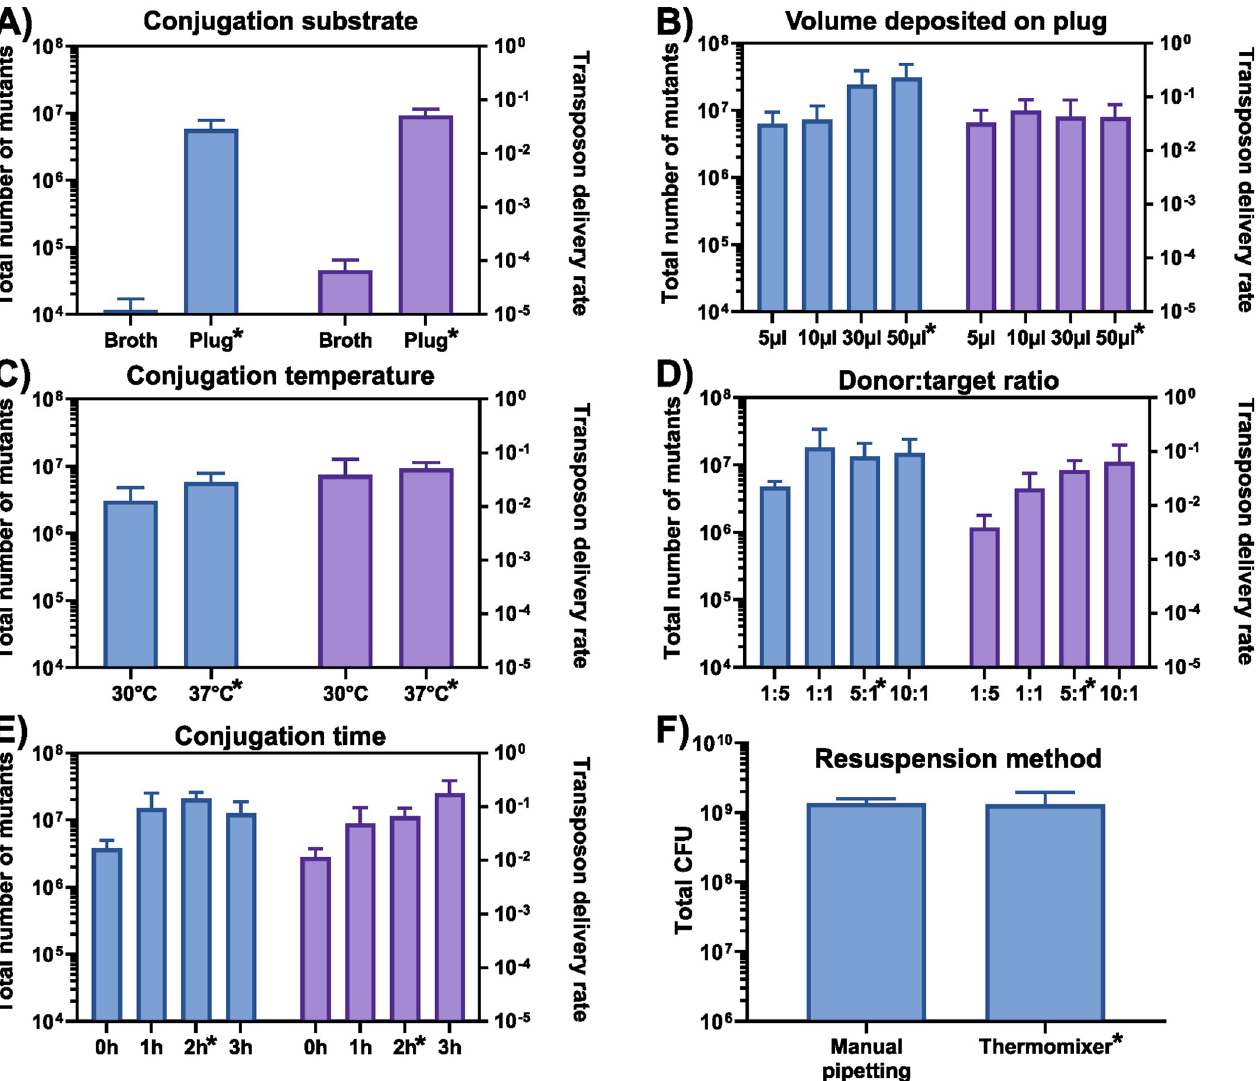
Fig 3. Optimization of key HTTM parameters. The total number of insertion mutants generated (blue) and the overall method efficiency (purple) were quantified while testing selected parameters such as A) the conjugation substrate (broth or agar plug), B) volume of conjugation mixture deposited on plug, C) conjugation temperature, D) the eAC494 donor to target cell ratio, and E) the duration of conjugative mating. F) Total number of colony forming units (CFU) recovered after the resuspension of the conjugative mixture using manual pipetting or the thermomixer procedure. The conditions selected for the standard HTTM protocol are indicated with an asterisk. Box and whiskers show mean and standard deviation across biological triplicates.